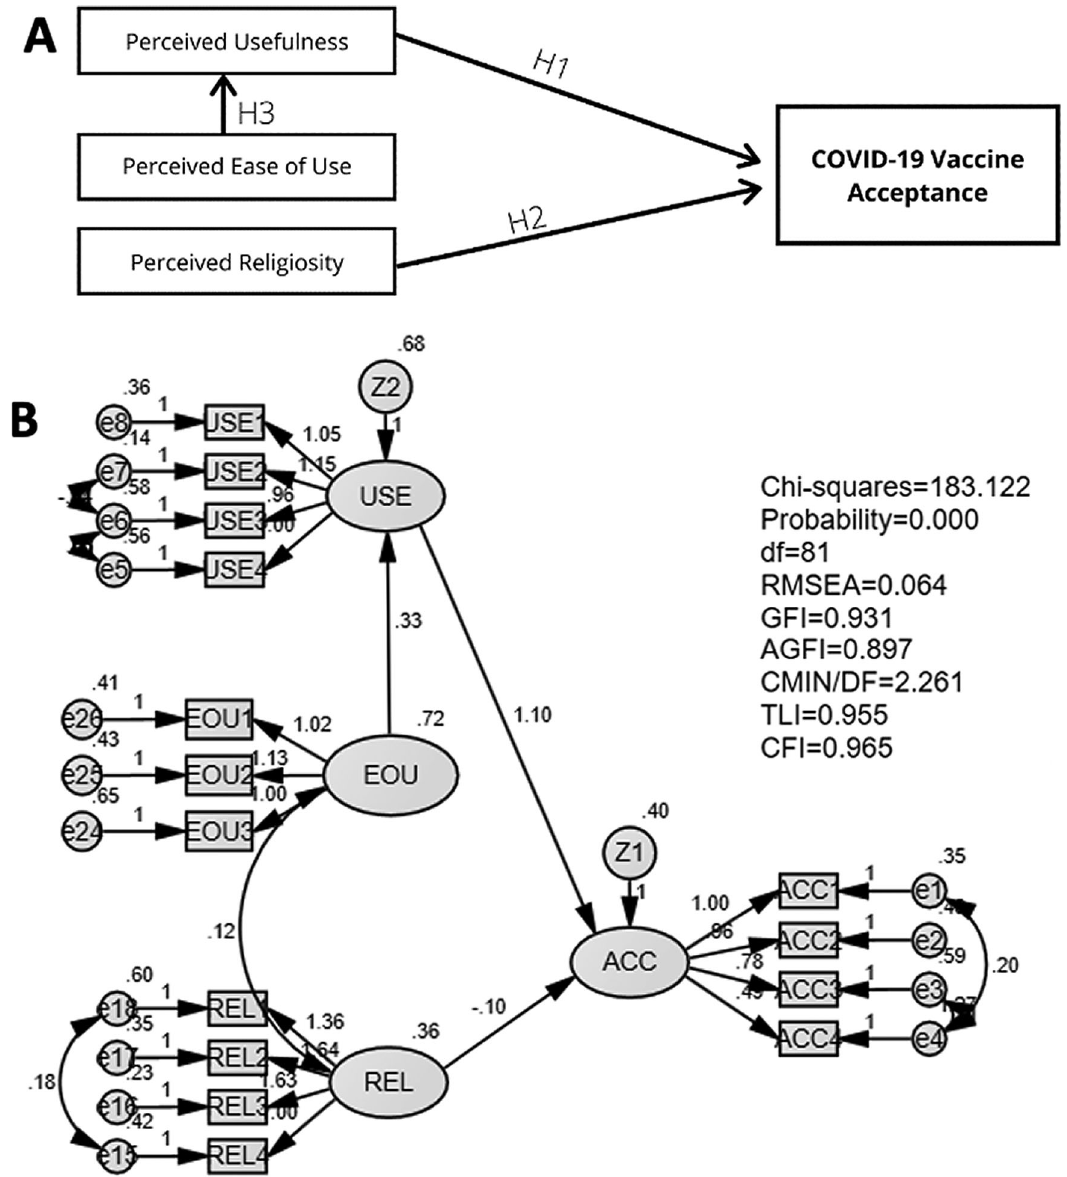
Figure 2. Modified model (A) and its goodness of fittest results (B) of the relationship of perceived usefulness, perceived ease of use, perceived religiosity, and amount of information on COVID-19 on vaccine acceptance.